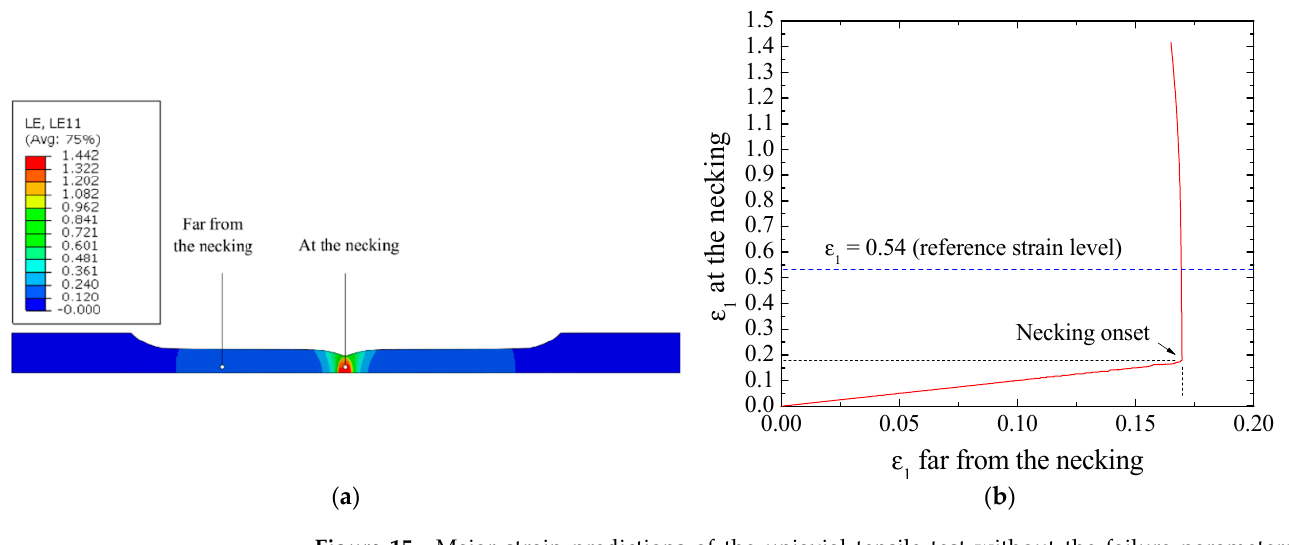
Figure 15. Major strain predictions of the uniaxial tensile test without the failure parameters: ( a ) regions at the necking and far from the necking and ( b ) corresponding major strain history.